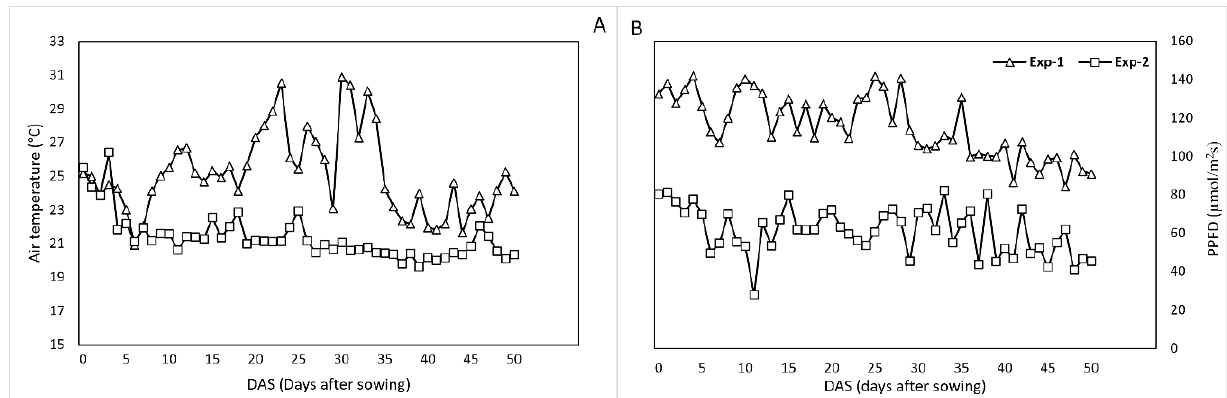
Figure 1. Daily average air temperature ( A ) and PPFD (photosynthetic photon flux density) ( B ) recorded during Exp-1 and Exp-2 to test the influence of rooting temperature on Chinese broccoli growth and quality in a glasshouse. DAS: days after sowing.